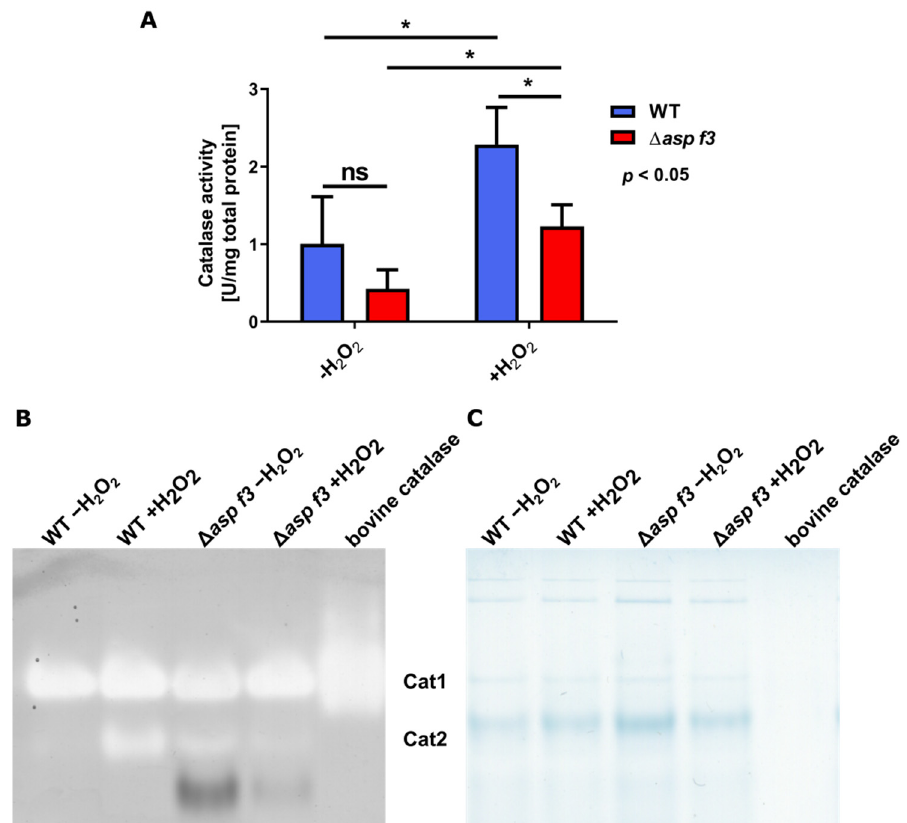
Figure 4. Catalase activity in hyphae of the wild type and the asp f3 deletion mutant of Aspergillus fumigatus. ( A ): Catalase activity was measured in total protein isolated from swollen spores 30 min after stress treatment with either 0 mM ( − H 2 O 2 ) or 2 mM (+H 2 O 2 ) H 2 O 2 . ( B ): Catalase activity staining was performed according to the method of Goldberg and Hochman [30]. Cultures of wild type and ∆ asp f3 were grown for 20 h and treated with 5 mM H 2 O 2 . Negative staining shows catalase activity of Cat1 and Cat2 as described previously [29,33] ( C ): Loading control stained with Coomassie. *: p <